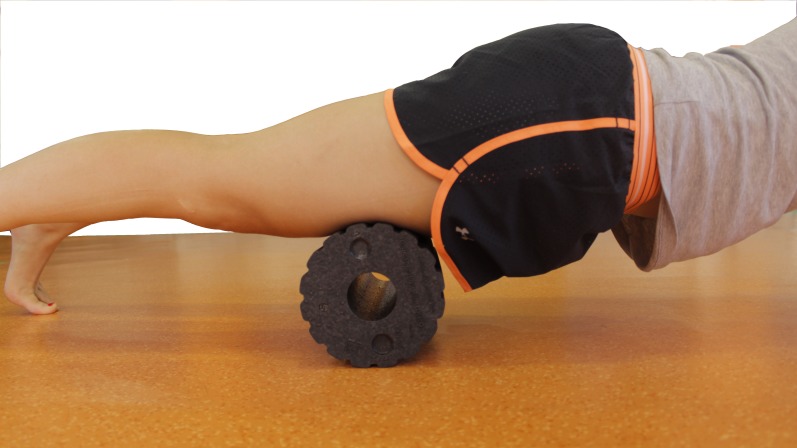
Myofascial foam-rolling technique.